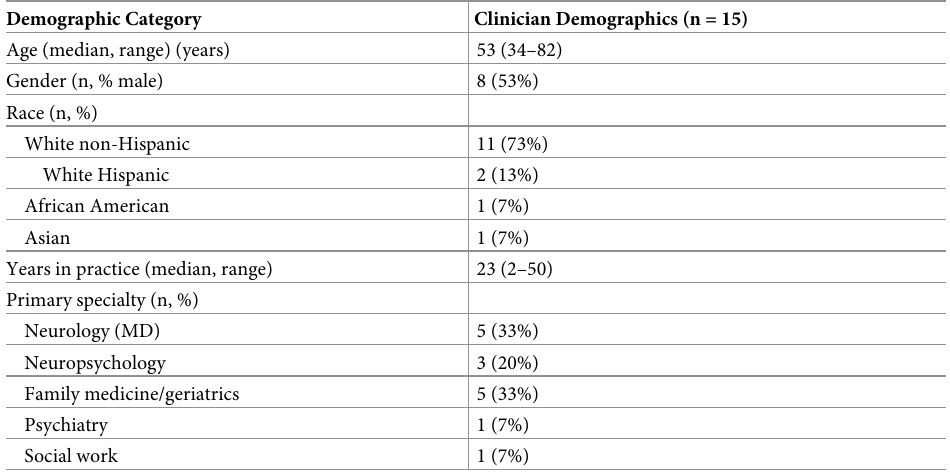
Table 1. Participant